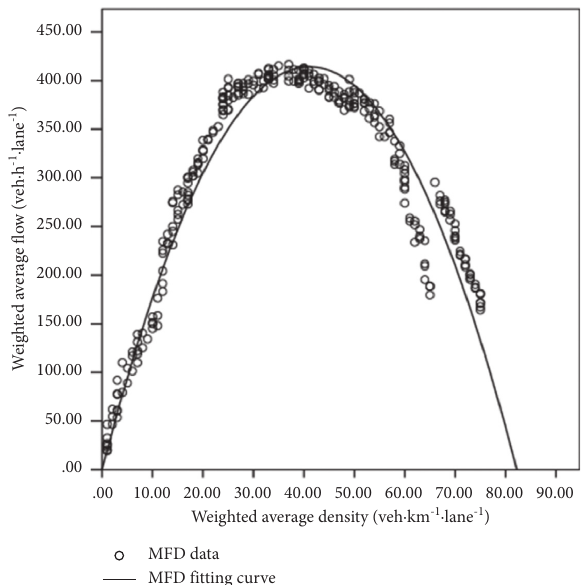
Figure 3: MFD scatter plot and fitting curve of the testbed